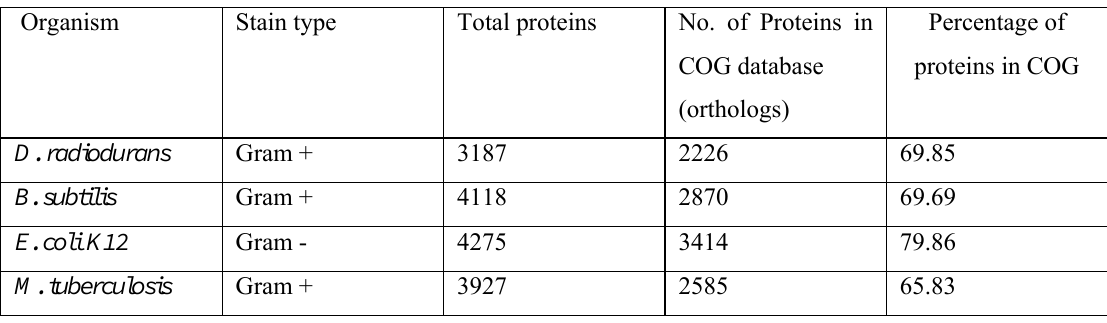
Table 1: Details of evolutionary conserved orthologs in the studied bacteria analyzed through Cluster of Orthologous Group (COG)